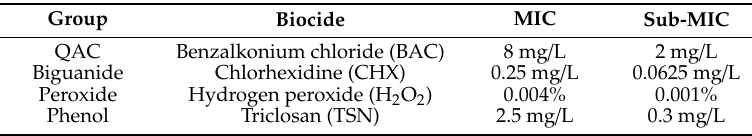
Table 1. Minimum inhibitory concentration (MIC) and subinhibitory minimum inhibitory concentration values (sub-MIC) of E. coli strain CFT073 for each biocide. The values were determined from three biological replicates.